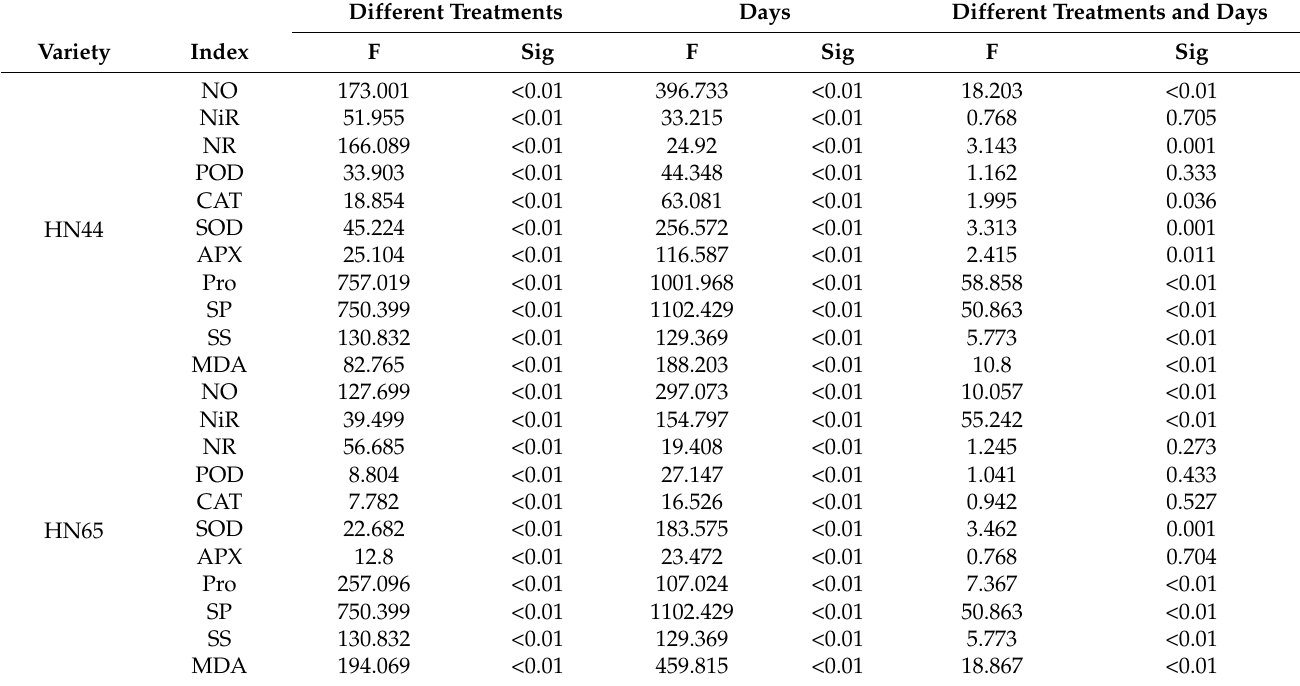
Table 2. Multifactor Analysis of Variance. Analysis of variance, using the F test method, the F value in the result represents a specific value obtained by the F test formula, and the corre- sponding p value is obtained according to the numerical table, which is sig. The sig value < 0.05 indicates that it affects the result, otherwise it has no effect. Different treatments are